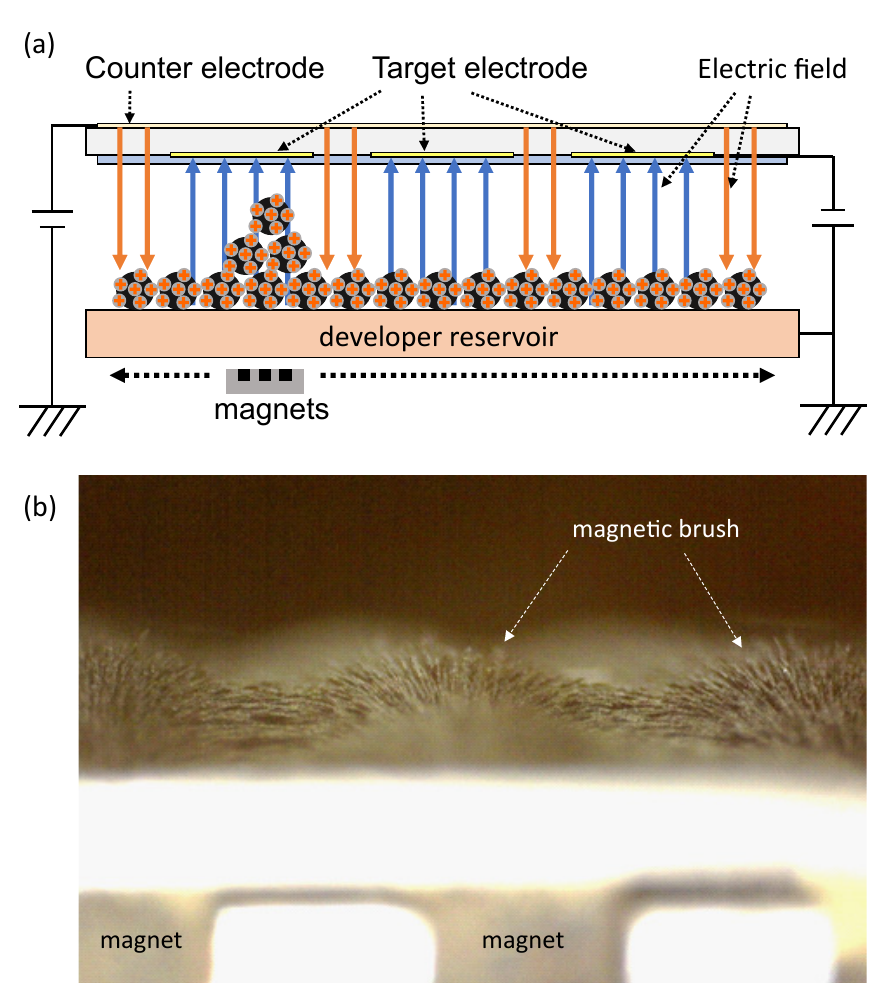
Figure 5. ( a ) Schematic illustration of the electrophotographic printing equipment. The developer particle, comprised of the toner and carrier, forms a magnetic brush structure along the magnetic lines of the force, and the magnets move in a reciprocating motion by a motorized mechanism. ( b ) Photograph of the magnetic brush formed in the developer